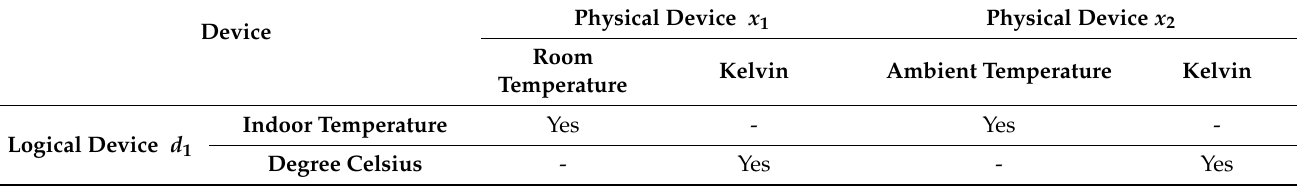
Table 1. Compatibility check result for logical device d 1 .